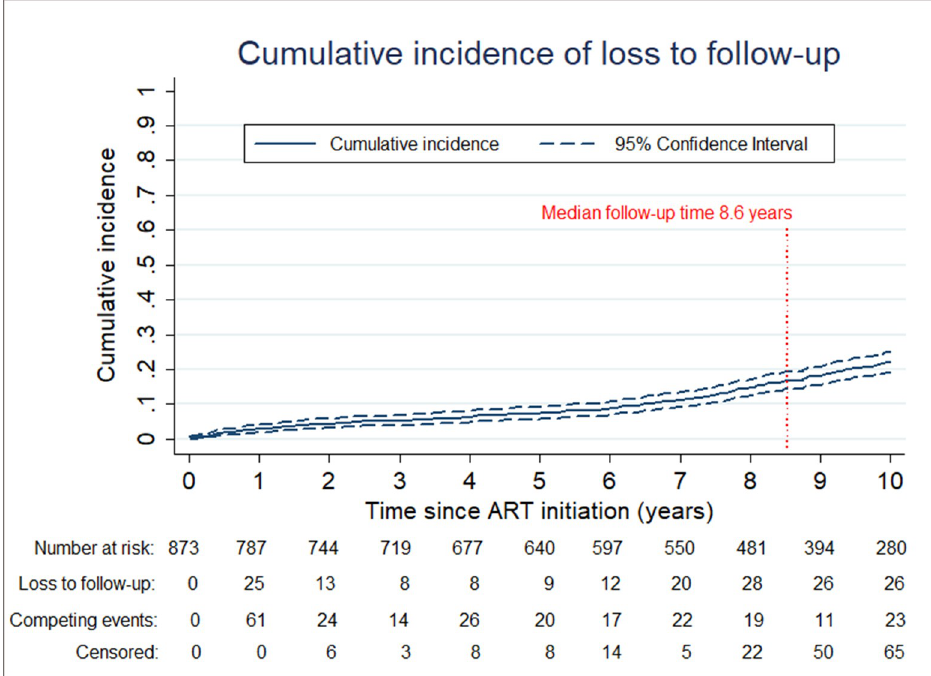
Fig 1. Cumulative incidence of loss to follow-up, with death and referral to another hospital accounted for as competing events.